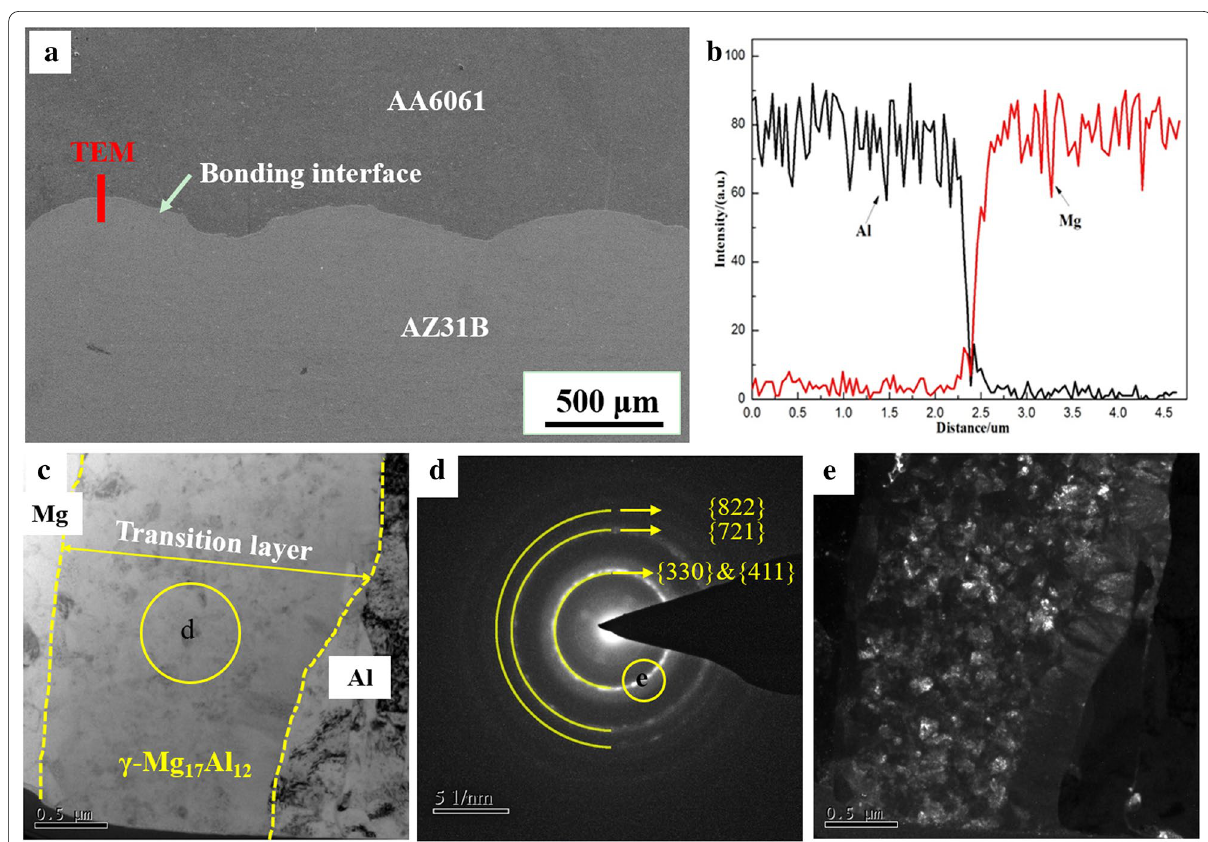
Figure 2 Typical sine wave interface of AA6061/AZ31B explosive welded clad plate: ( a ) BSE image of the bonding interface; ( b ) EDS line scan along the bonding interface; ( c ) TEM images of the bonding interface; ( d ) Selected area electron diffraction pattern obtained from region d in ( c ); and ( e ) Dark-field images of the transition layer obtained from the part of diffraction ring e in ( d